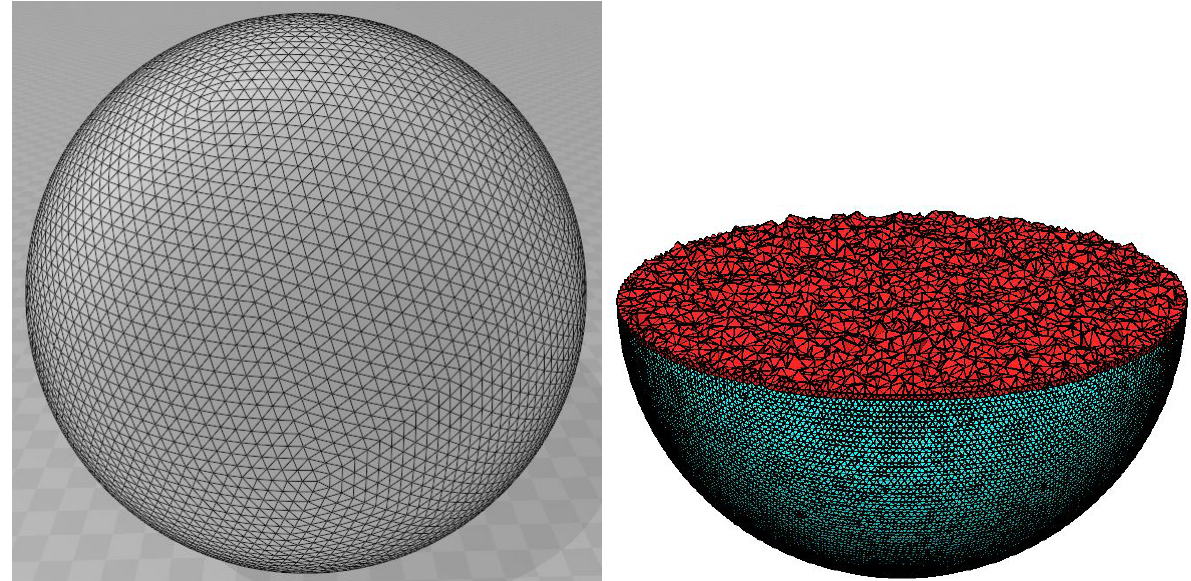
Figure 1. The surface ( left ) and the tetrahedral mesh ( right ) of a geosphere.